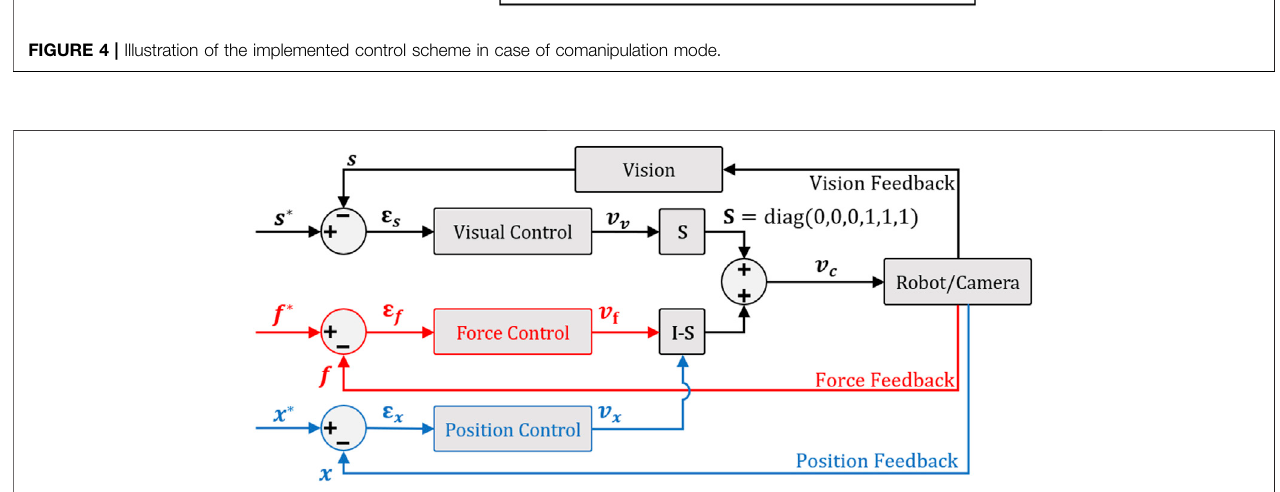
FIGURE 5 | Parallel hybrid force/vision comanipulation (in red) and position/vision teleoperation (in blue) control